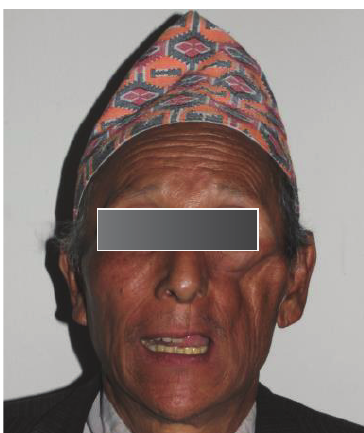
Figure 3: Final impression of maxillary arch.